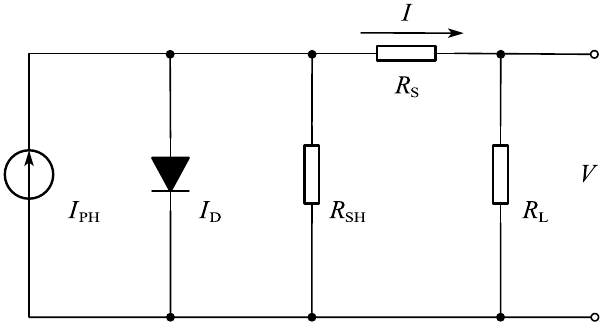
Figure 2. DC model of solar